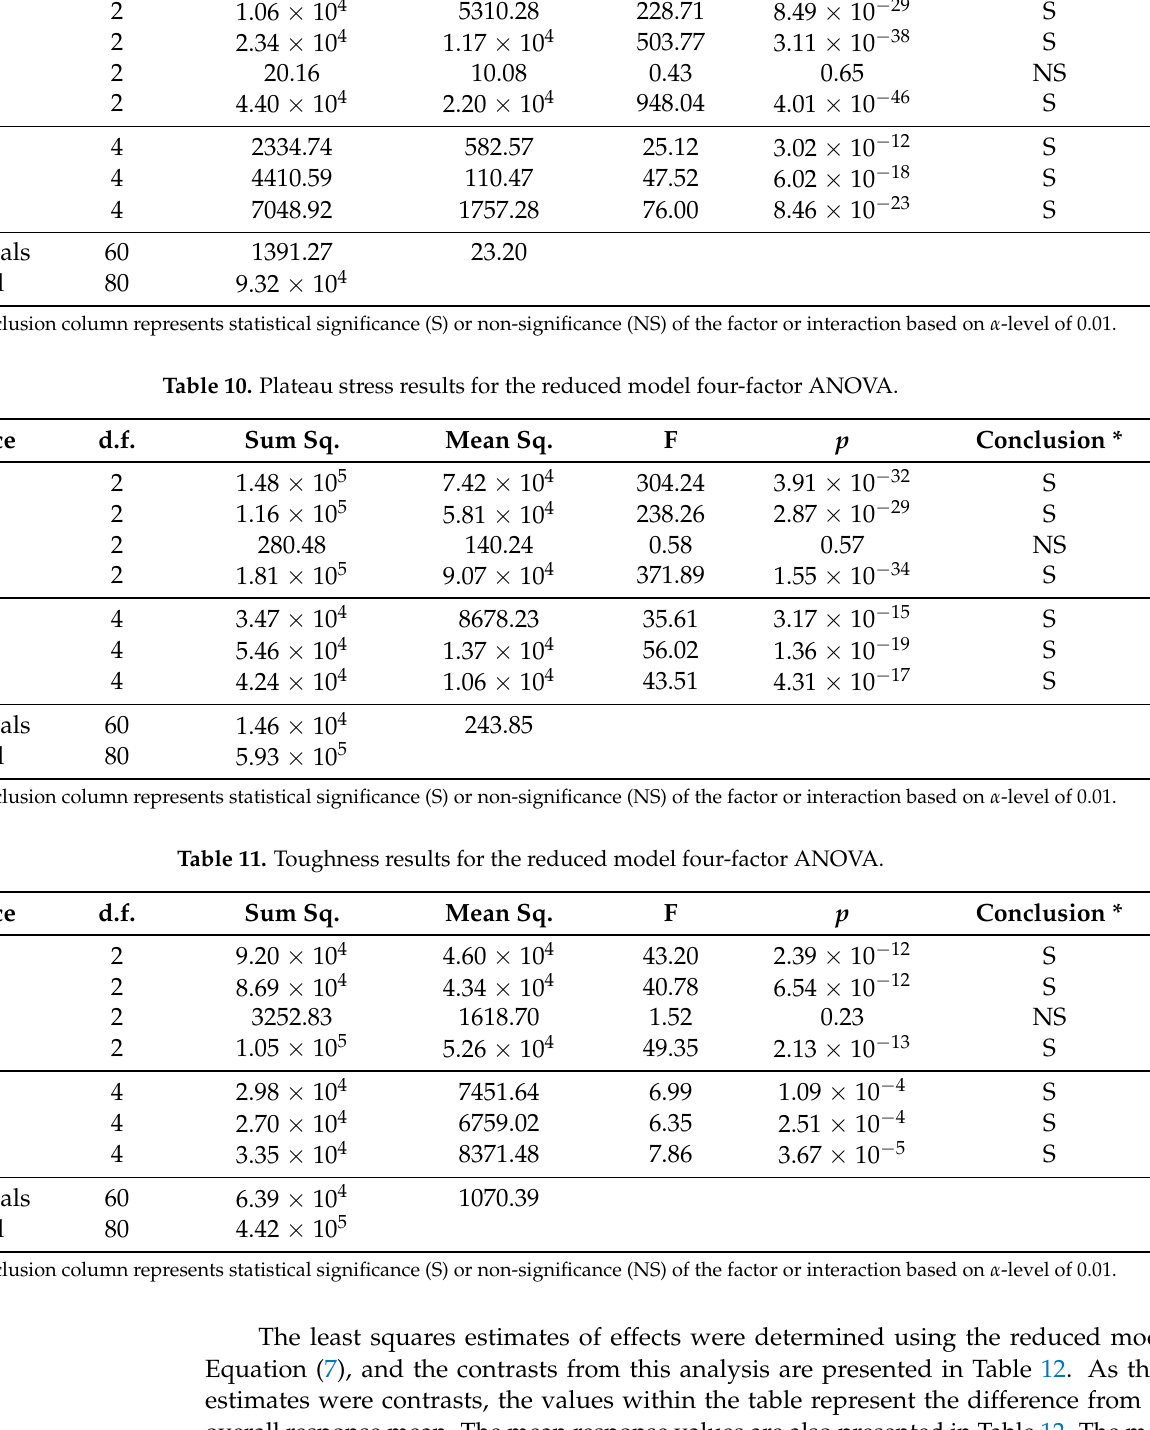
overall response mean. The mean response values are also presented in Table 12. The mean error of the model, considering all four of the material properties, was − 9.53 × 10 − 15 . Additionally, confidence intervals were computed for the mechanical property estimates using the reduced interaction model, shown in Table 13. The confidence intervals were based on a t-distribution and were determined utilizing the residual degrees of freedom and mean square